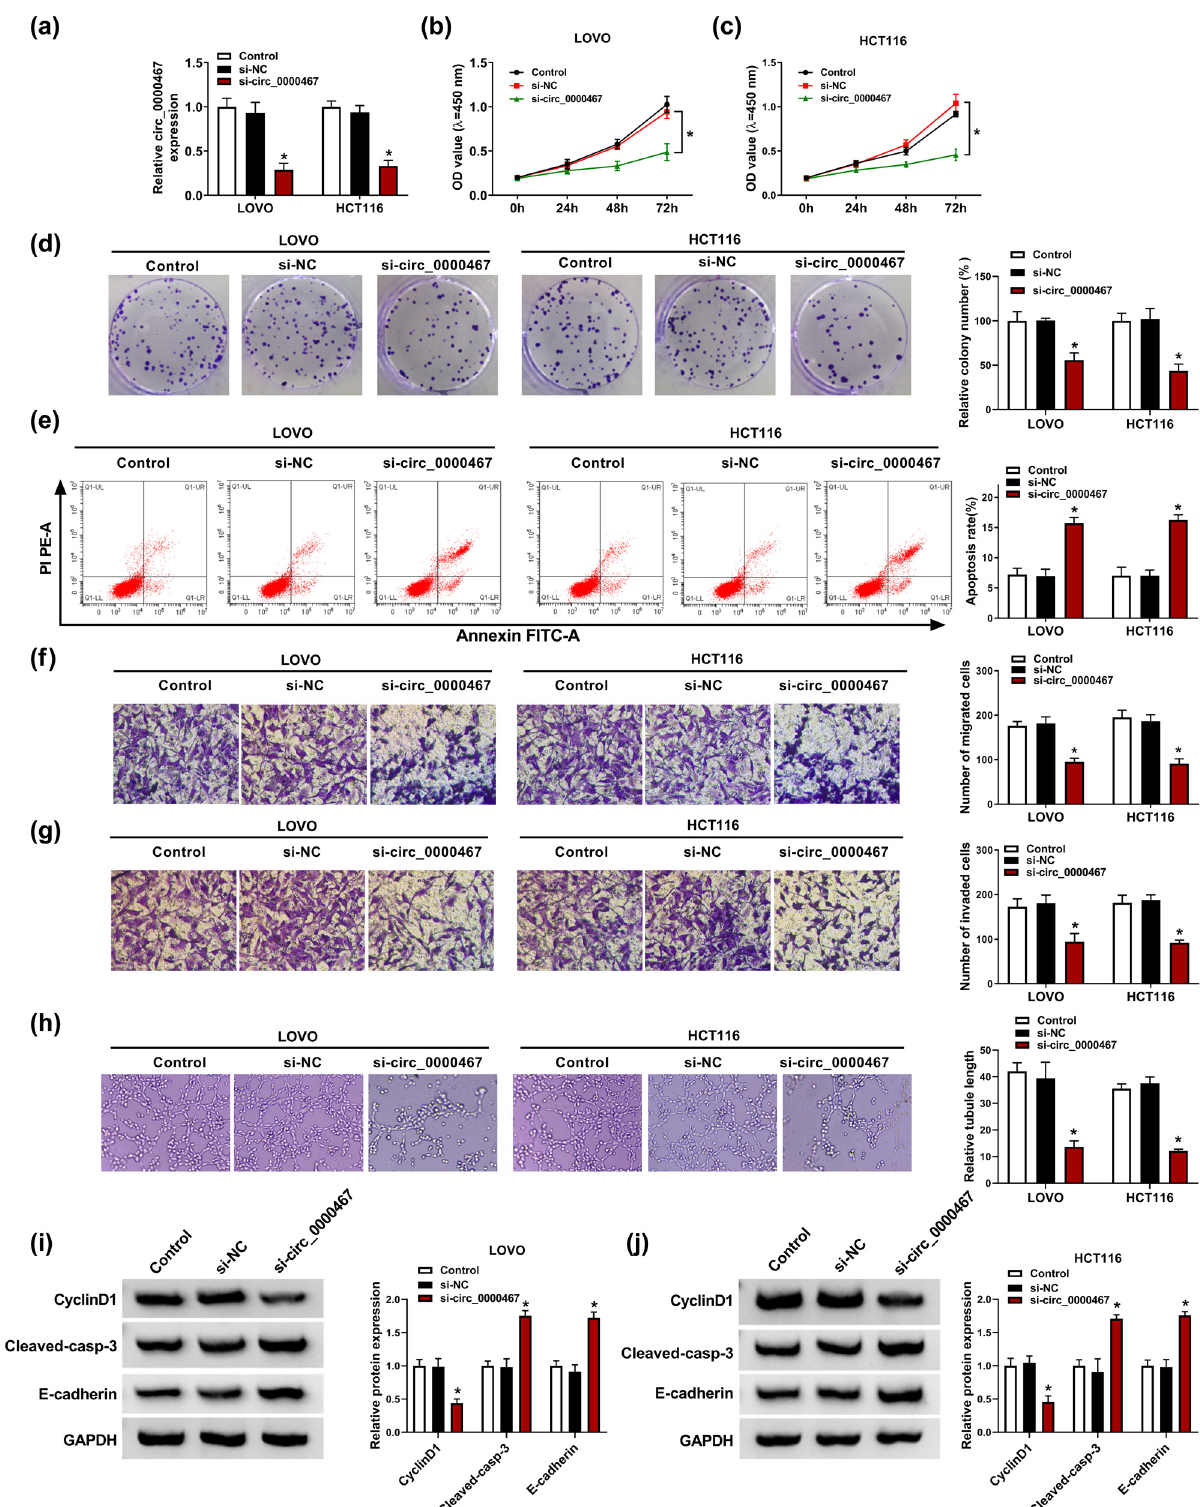
Figure 2: Knockdown of circ_0000467 inhibited CRC cell proliferation, migration, and invasion but promoted apoptosis. LOVO and HCT116 cells were transfected with si - circ_0000467 or si - NC, with untransfected cells as the control group. ( a ) The interfering e ff ectiveness of si - circ_0000467 was detected by RT - qPCR. ( b – d ) Cell proliferation was examined by CCK - 8 assay ( b and c ) and colony formation assay ( d ) . ( e ) Cell apoptosis was analyzed by fl ow cytometry. ( f and g ) Cell metastasis was determined by transwell migration ( f ) or invasion ( g ) assay. ( h ) Angiogenesis was assessed by tube formation assay. ( i and j ) CyclinD1, cleaved - casp - 3, and E - cadherin protein levels were assayed by WB. * P <